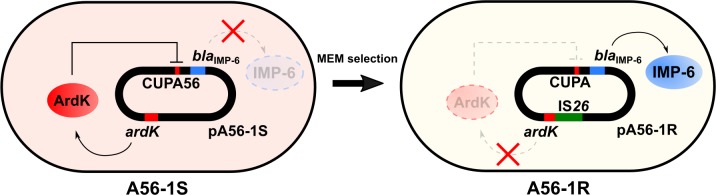
Schematic representation of the transcriptional regulation of blaIMP-6 by ArdK.